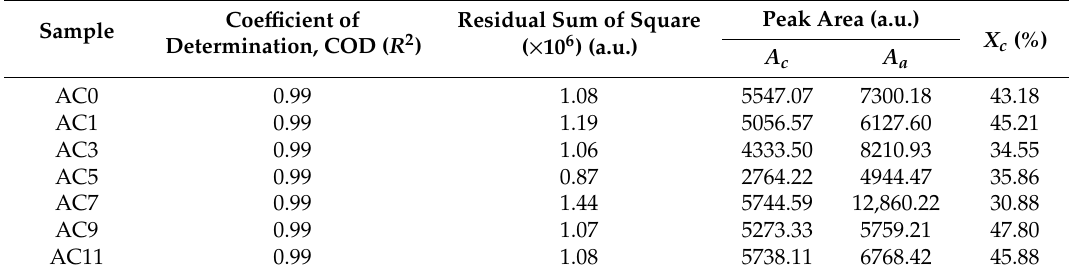
Table 2. The respective area of crystalline ( A c ) and amorphous ( A a ) phase and degree of crystallinity ( X c ) of each CMC-AC biopolymer